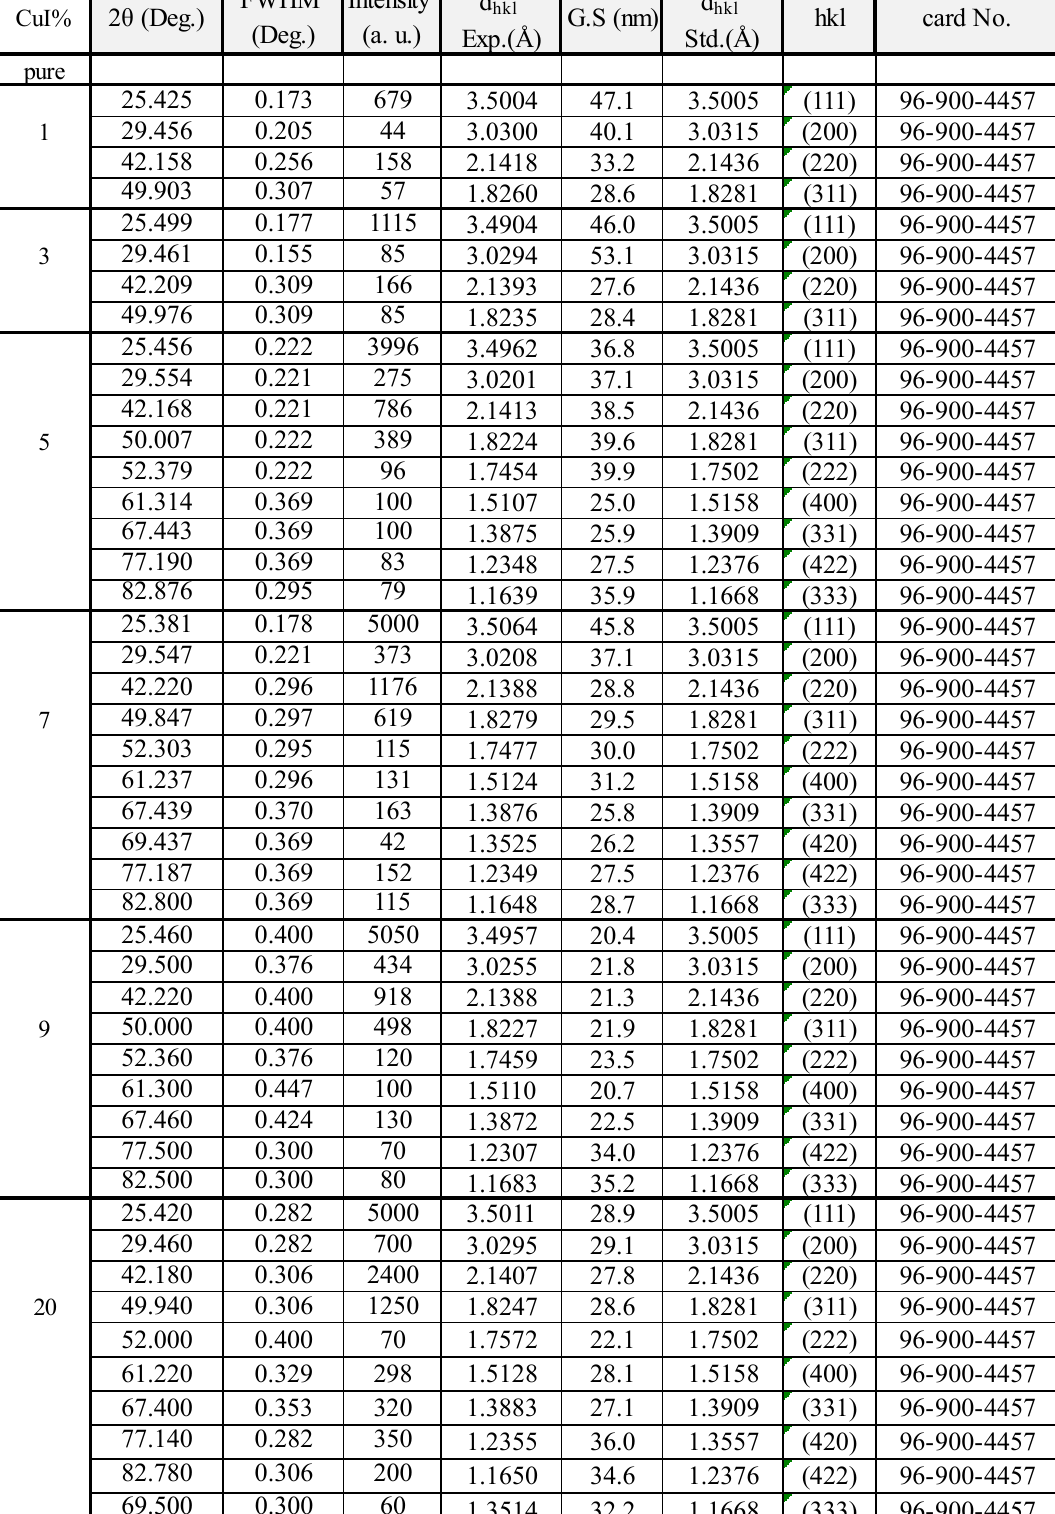
Table 2: XRD paramètres of (PVA\CuI) polymer